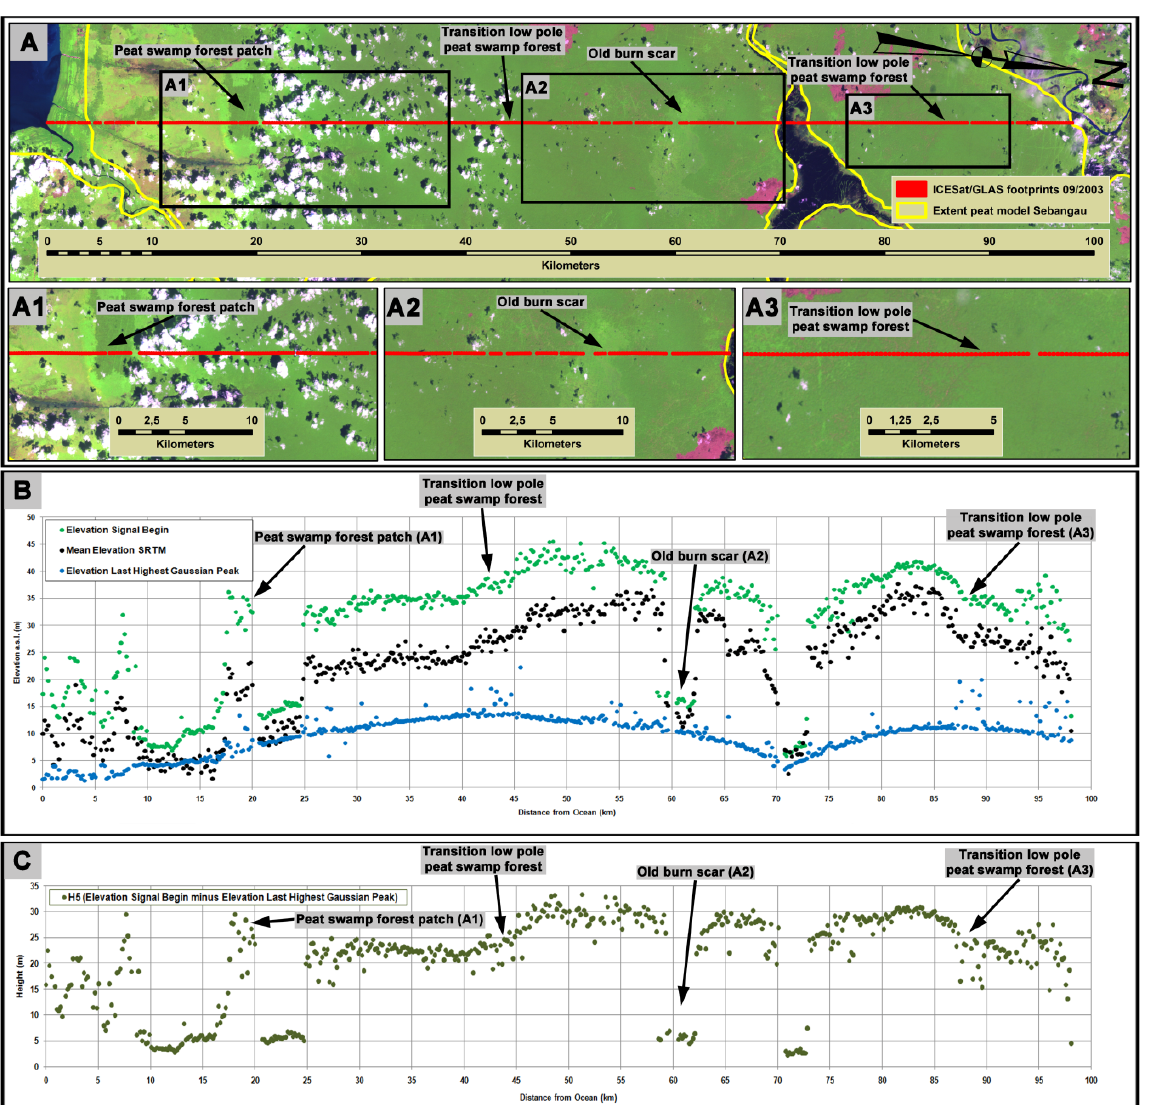
Figure 7. ICESat/GLAS transect covering the Sebangau peatland area from south to north. The transect of 98 km length starts at the ocean in the south then transects heavily degraded forest, logged peat swamp forest, an old burn scar, and further north a lake, and peat swamp forest again. ( A ): ICESat/GLAS transect superimposed on a Landsat ETM+ image (22-05-2003, bands 5, 4, 3). Bright green represents degraded forest, dark green peat swamp forest. A1–A3 : Three enlarged areas within this ICESat/GLAS footprint transect. The locations of these areas are indicated by the three black rectangles in A; ( B ): Elevation profile of the ICESat/GLAS transect. Shown are the ICESat/GLAS elevations for the forest canopy (green) and the peat surface (blue). Note the curvature of the peat dome. Also displayed is the mean elevation at footprint location from the SRTM data (black). The locations of a peat swamp forest fragment, two low pole peat swamp forest transition zones, and an old burn scar are indicated by black arrows; ( C ): Measurement of absolute vegetation height by subtracting ICESat/GLAS peat surface elevation from ICESat/GLAS forest canopy signals (ICESat/GLAS height metric